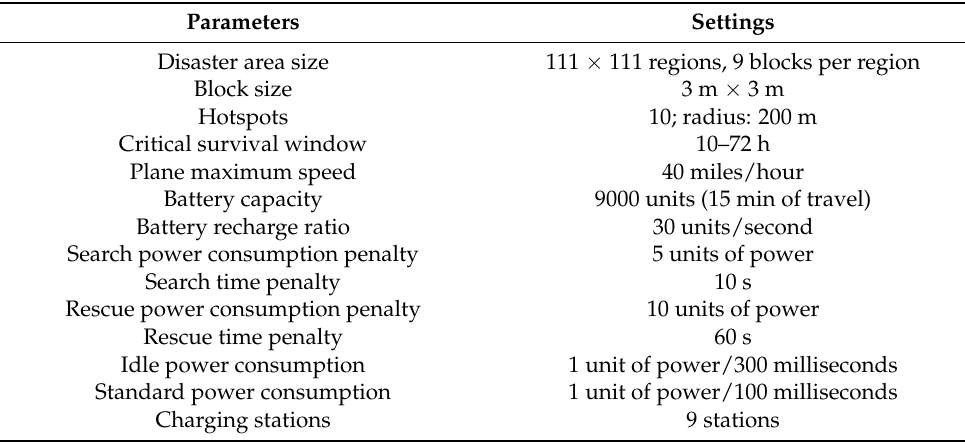
Table 1. Parameter settings of the evaluation